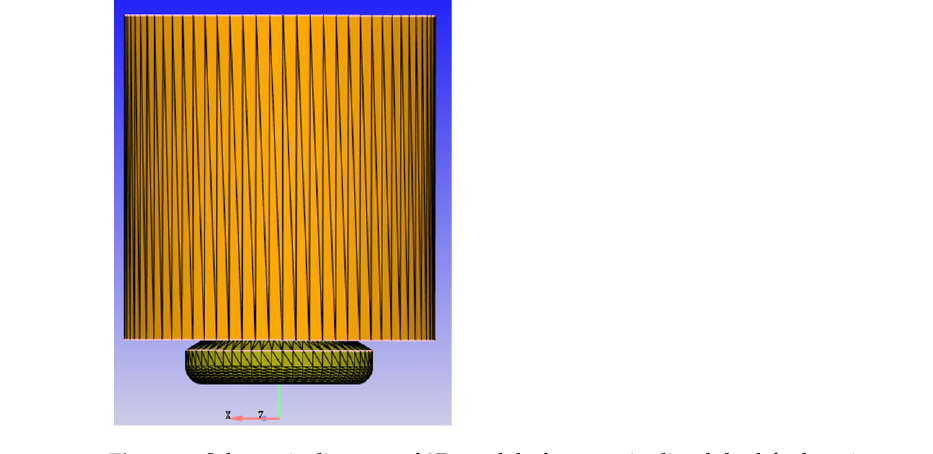
Figure 1. Schematic diagram of 3D model of ammonia-diesel dual-fuel engine. Table 4. Parameters of diesel injection.